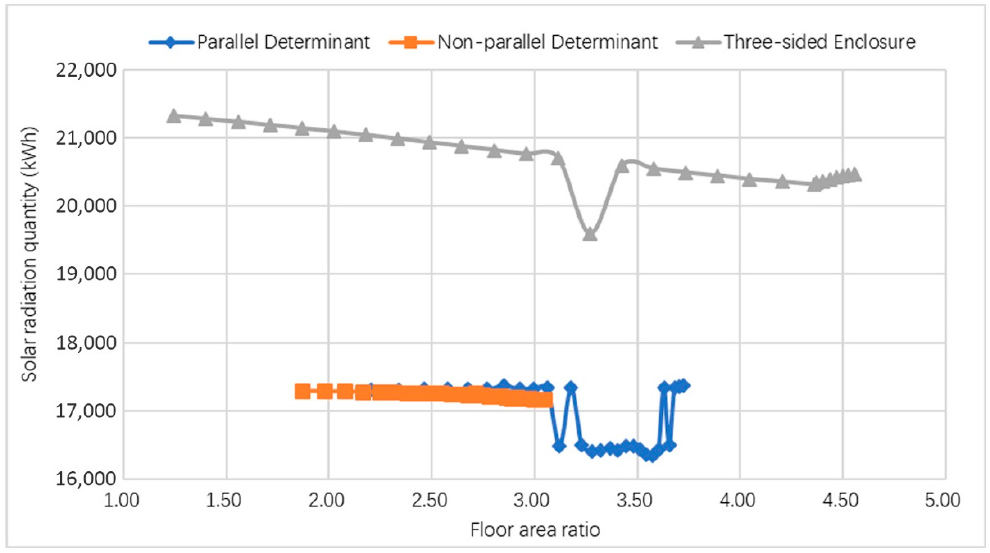
Figure 7. Relationship between floor area ratio and solar radiation quantity.